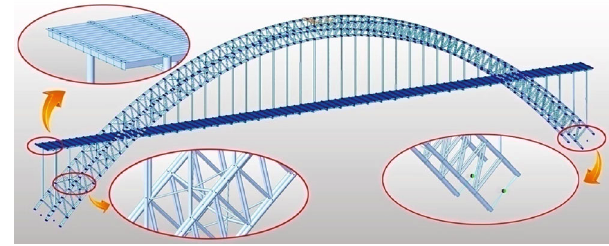
Figure 2: Finite element model of the bridge.